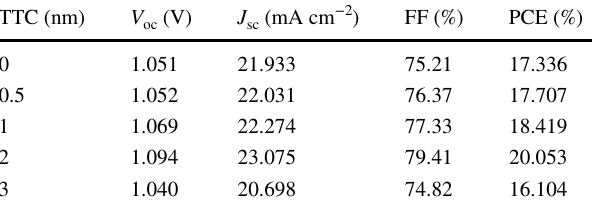
Table 1 Average performance parameters of perovskite devices with different thicknesses of TTC tunneling layers TTC